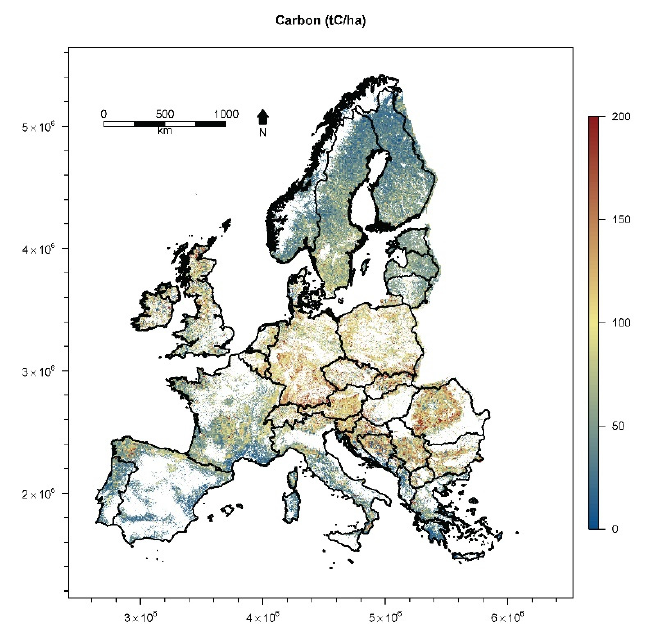
Figure 8. Map showing carbon content (tC/ha) only for 500 × 500 m cells with a with a minimum tree cover of at least 5% (1.25 ha) according to the MODIS land cover classification. This map can be combined with MODIS land cover data to calculate total carbon content (tC) for each 500 × 500 m cell. By summing up cell values, total biomass at regional or country level can be estimated. In this figure, values higher than 200 tC/ha area truncated for display reasons.